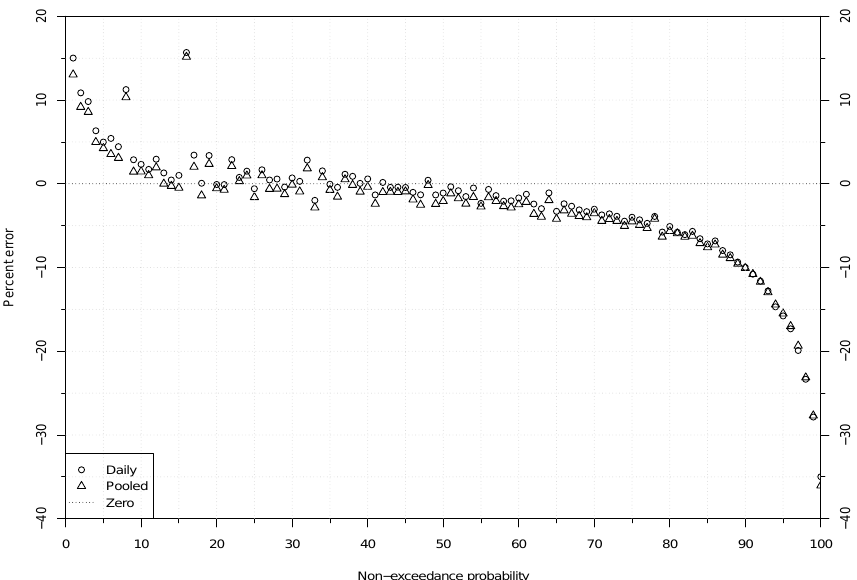
Figure 4. Median percent error for each non-exceedance probability, binned by single percentage points, for streamflow estimates from both daily and pooled variogram parameter sets.